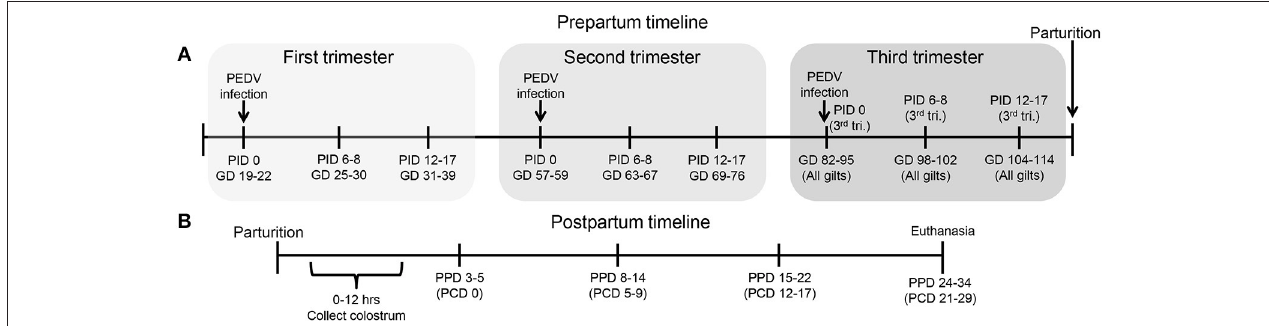
FIGURE 1 | Schematic diagram of the experimental design showing gilt porcine epidemic diarrhea virus (PEDV) infection and sample time points at post infection day (PID) 0, 6–8, 12–17 and gestation day (GD) 82–95, 98–102, and 104–114, (B) piglet PEDV challenge at 3–5 postpartum day (PPD) and sample time points at PPD